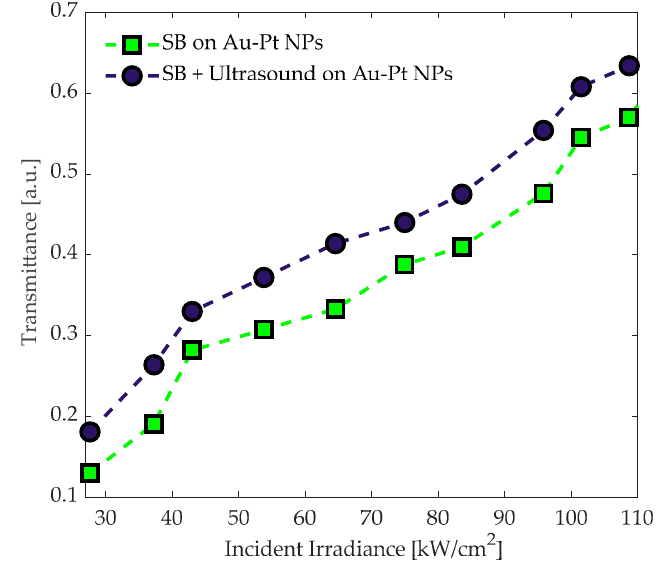
Figure 6. Change in the single-beam transmittance by the ultrasonic waves propagated through the Au-Pt NPs suspended in ethanol.